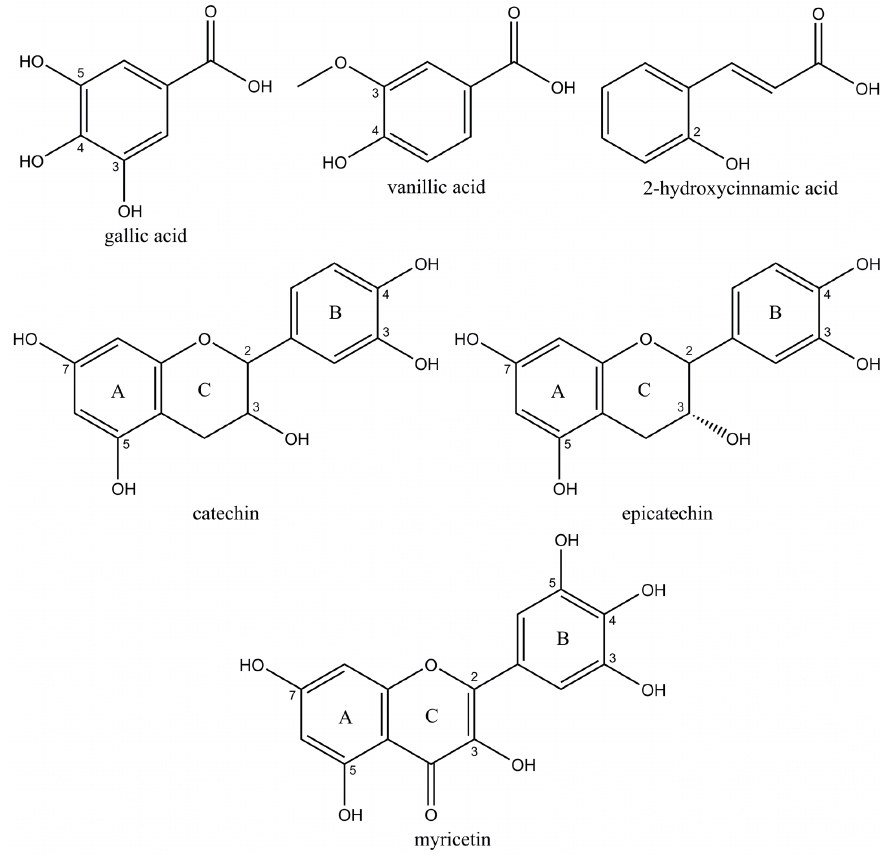
Fig. 6: Molecular structure and substituent position of identified phenolics in pineapple cv. Esmeralda. Gallic acid, vanillic acid and 2-hydroxycinnamic acid are simple phenolic acids with one (vanillic acid and 2-hydroxycinnamic acid) or three (gallic acid) hydroxyl groups. Catechin, epicatechin and myri- cetin are flavonoids of more complex structure that have five (catechin and epicatechin) or six (myricetin) hydroxyl